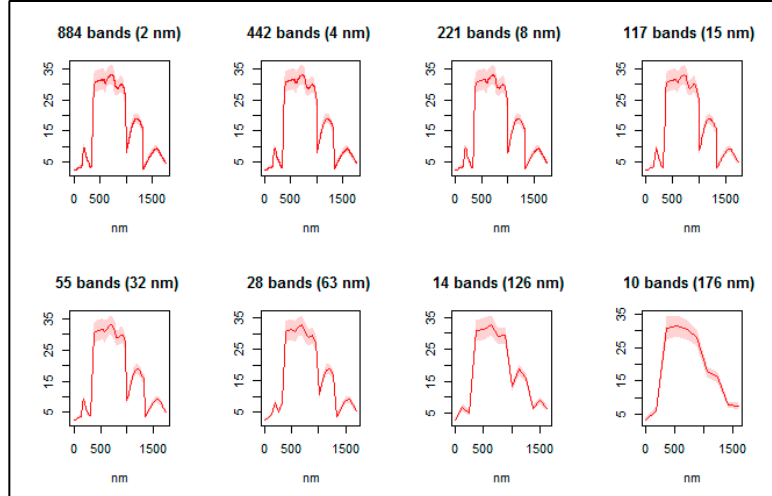
Figure 6. Resampling of the original hyperspectral dataset. Subsets of bands ranged in size from n = 884 (spectral resampling to 2 nm) to n = 10 (spectral resampling to 176 nm). The X -axis represents the wavelength (nm) of the resampled bands whereas the Y -axis represents the reflectance (%).